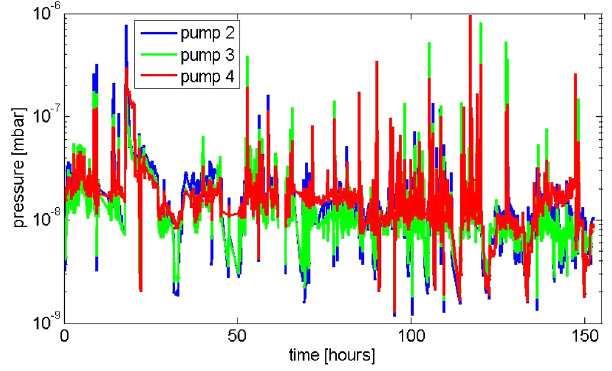
FIG. 24. Vacuum level measured during the gun